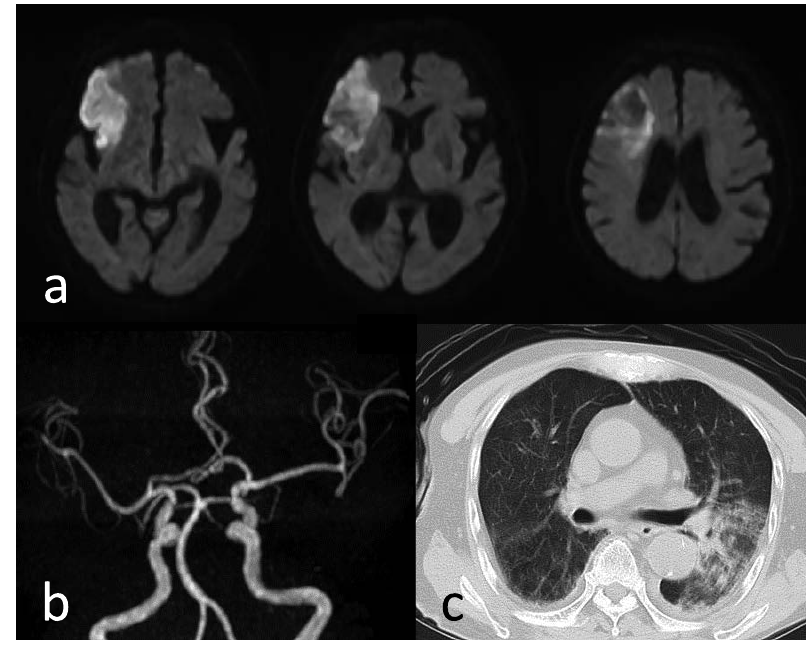
Figure 4 Case 8: 89-year-old male. Cerebral infarction was a single lesion, and it was massive (over 15 mm). a Brain MR DWI showed cerebral infarction in the anterior half of the right middle cerebral artery region. b MRA indicated the possibility that a branch of the middle cerebral artery was occluded. c Chest CT showed pneumonia.